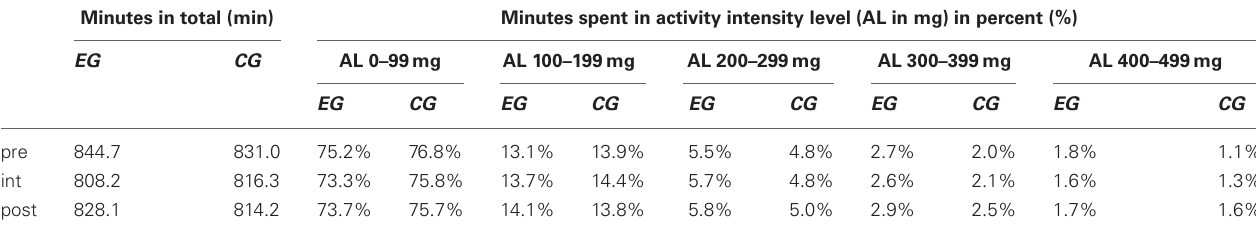
Table 2 | Percentage of minutes spent in different activity intensity levels (mg) pre, during, and post the intervention period for CG and EG . Minutes in total (min)